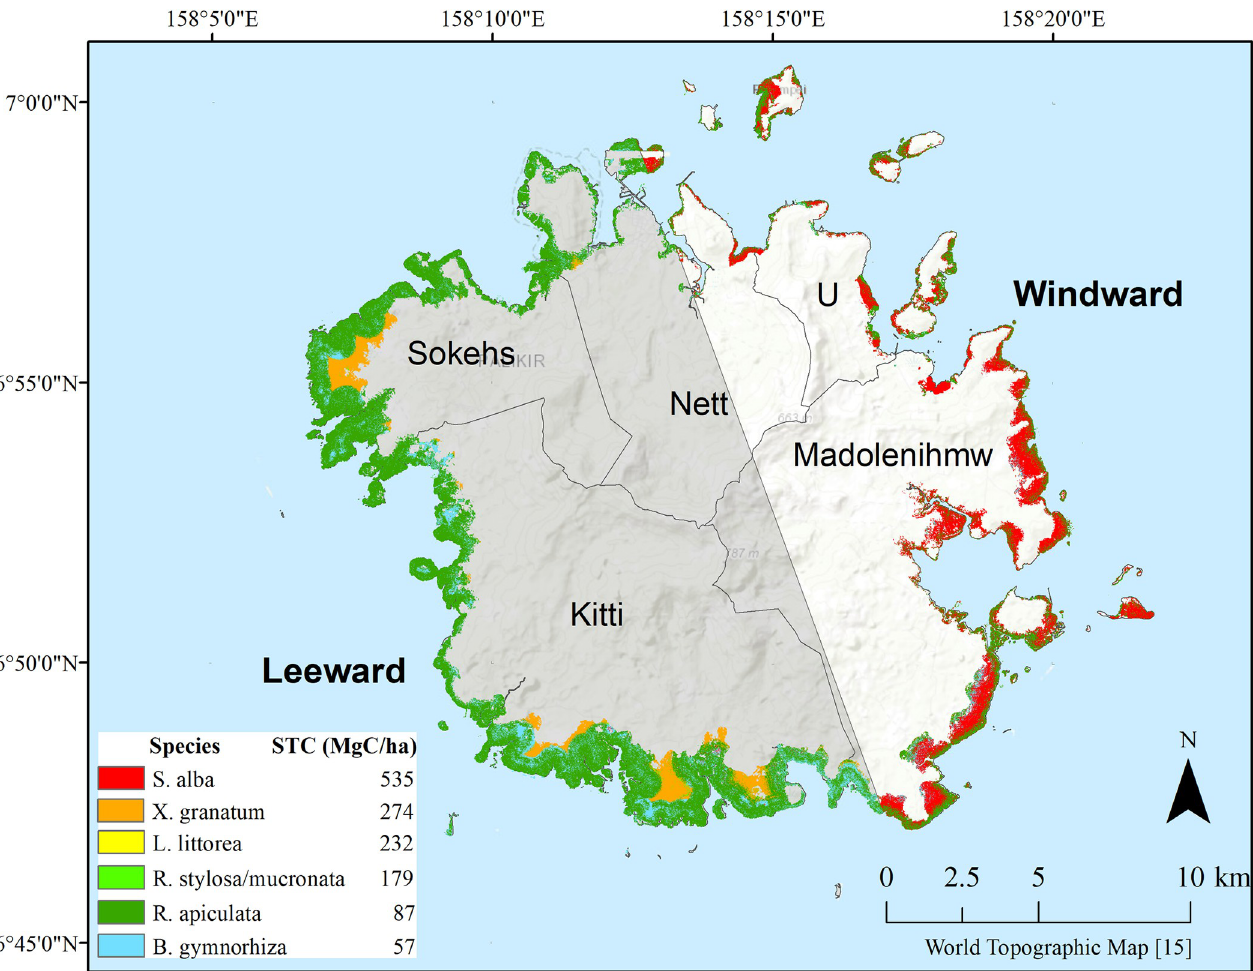
Fig 3. Dominant mangrove species. Dominant mangrove species and associated standing tree carbon (STC) stock (MgC ha -1 ) in 5 by 5 meter cells mapped using the k-nearest neighbor method, overlaid on Esri’s topographic basemap of the island of Pohnpei [15]. Municipality names and windward and leeward island sides (translucent white and grey, respectively) are also shown on the